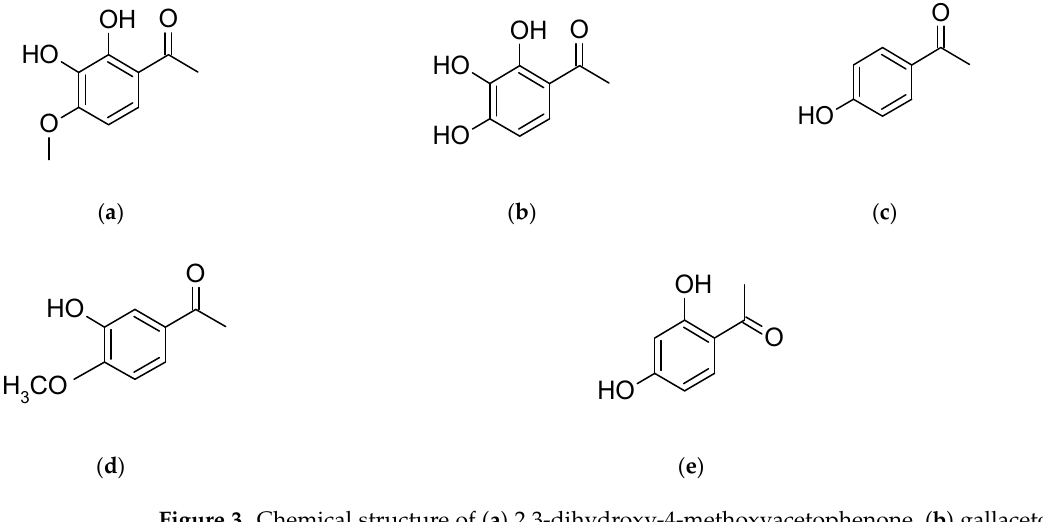
Figure 3. Chemical structure of ( a ) 2,3-dihydroxy-4-methoxyacetophenone, ( b ) gallacetophenone, ( c ) p -hydroxyacetophenone, ( d ) 3-hydroxy-4-methoxyacetophenone, ( e ) reacetophenone.